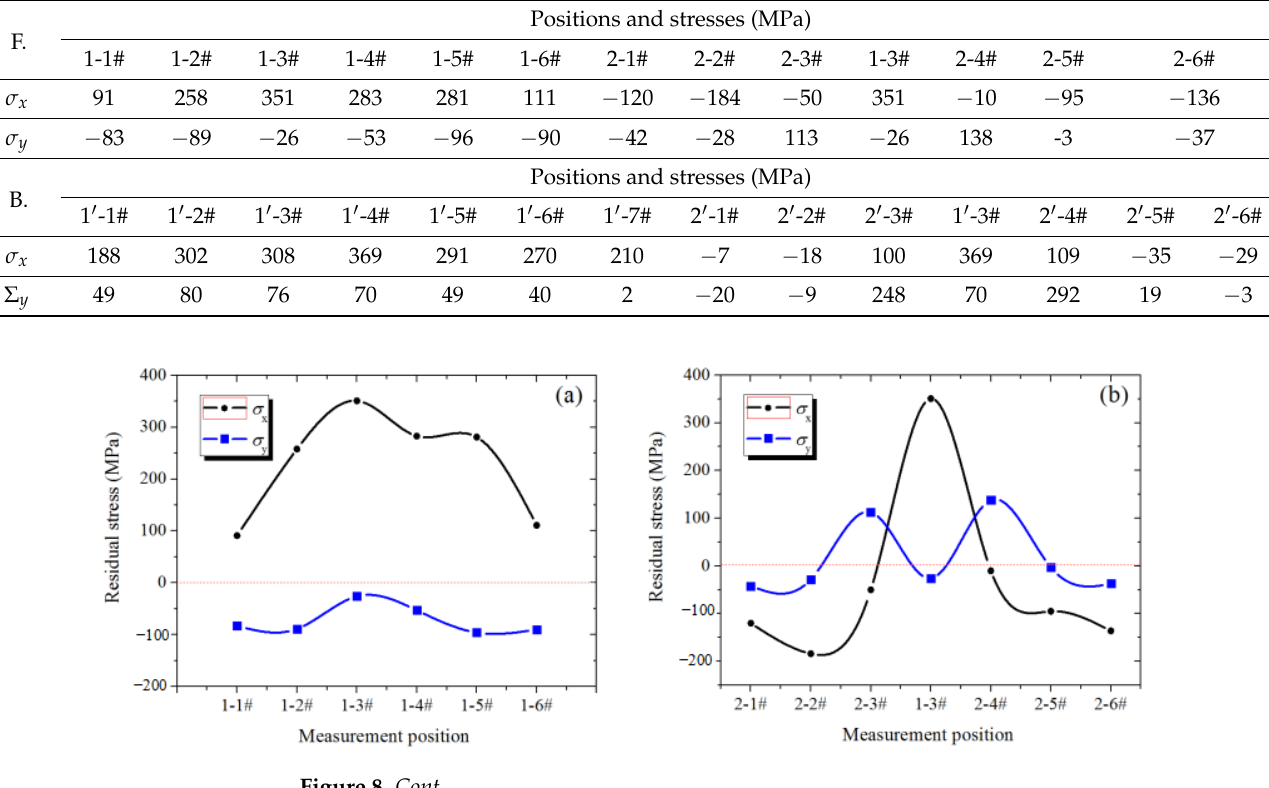
Figure 8. Residual stress measurement results in front surface—( a , b ) and in back surface—( c , d ). 3.2. Fatigue Experiment In the present study, the welded Ti-6Al-4V ELI joints are in the as-weld condition. No surface processing and post-processing are conducted for removing underfills or re- inforcements. Load-controlled uniaxial fatigue tests are conducted at room temperature in a 100 KN servo-hydraulic testing machine and an applied ratio is R = 0.1. The connec- tion between the test piece and the fatigue testing machine is the special fixture, which is a cylindrical hinge to minimize the additional load generated by the clamp during loading. The photographs of the test piece, the diagram of special fixture and the test setup can be seen in Figure 9a–c. ( a ) ( b ) ( c ) Figure 9. ( a ) The photographs of the test piece; ( b ) The diagram of the special fixture; ( c ) Test setup. The fatigue life of the welded joint in as-weld condition with some surface defects will be certainly poorer with stress concentrations, but it can be applied for conservative consideration. In the compression state, cracks are less likely to expand. To shorten the